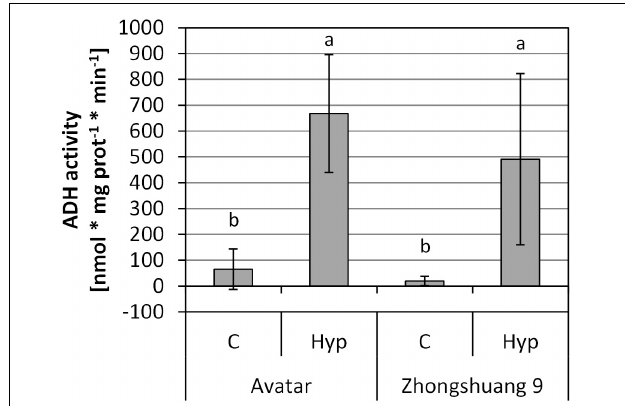
FIGURE 3 | ADH activity [nmol ∗ mg prot − 1 ∗ min − 1 ] in roots of two Brassica napus cultivars (Avatar, Zhongshuang 9) in hydroponics after 3 days of root hypoxia, compared with aerated controls. At time of harvest, plants were 18 days old. Data are means ± SD of 4 to 5 replicates. Different letters indicate significant differences (ANOVA and Tukey post hoc test, p < 0.05).